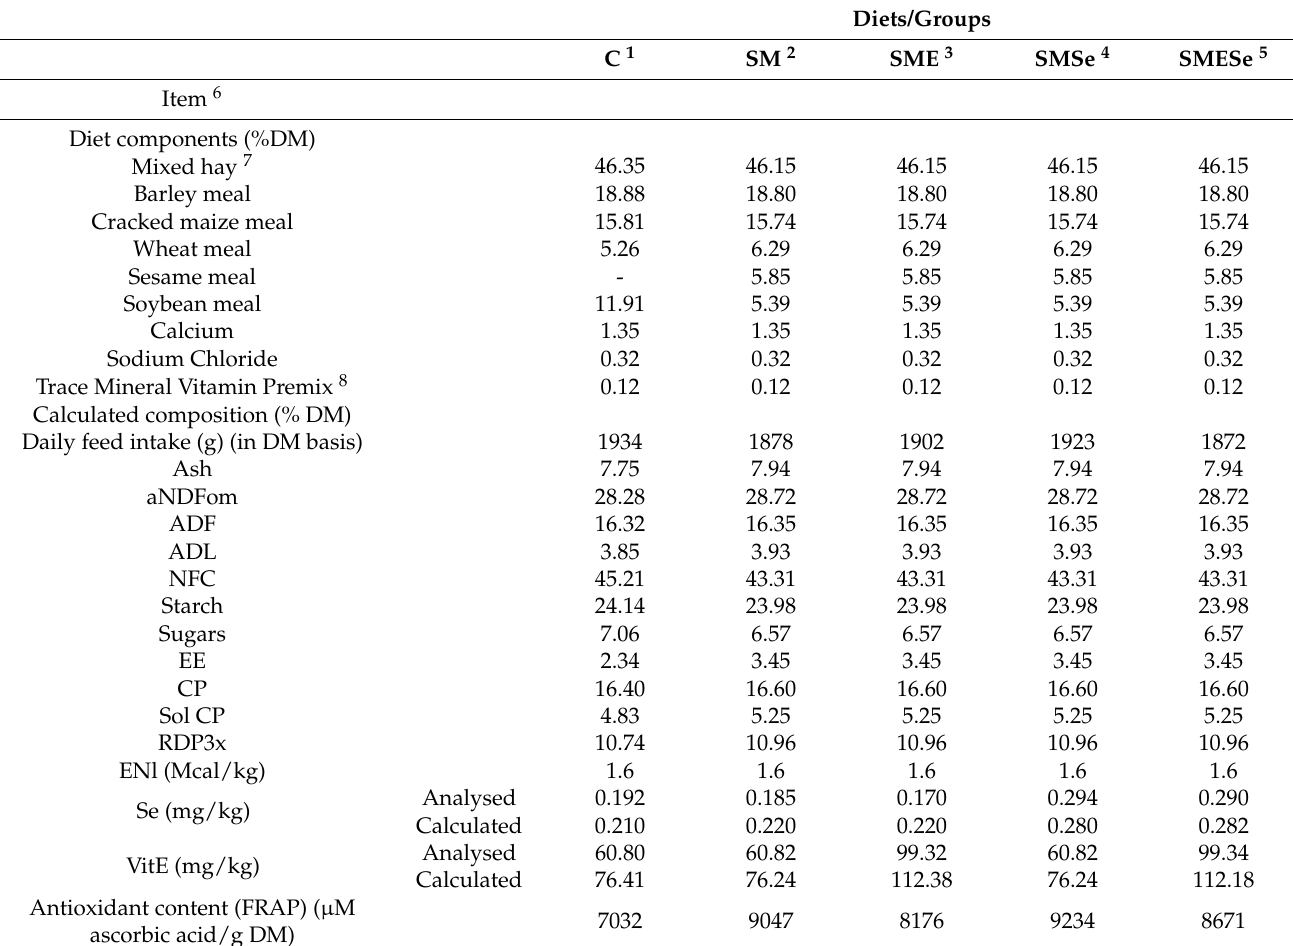
Table 1. Components, calculated composition, and Se and vitE concentrations of the diets administered to the groups of dairy goats involved in the